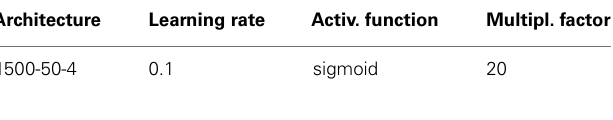
Table 1 | Final parameters for training of theTL module. Architecture